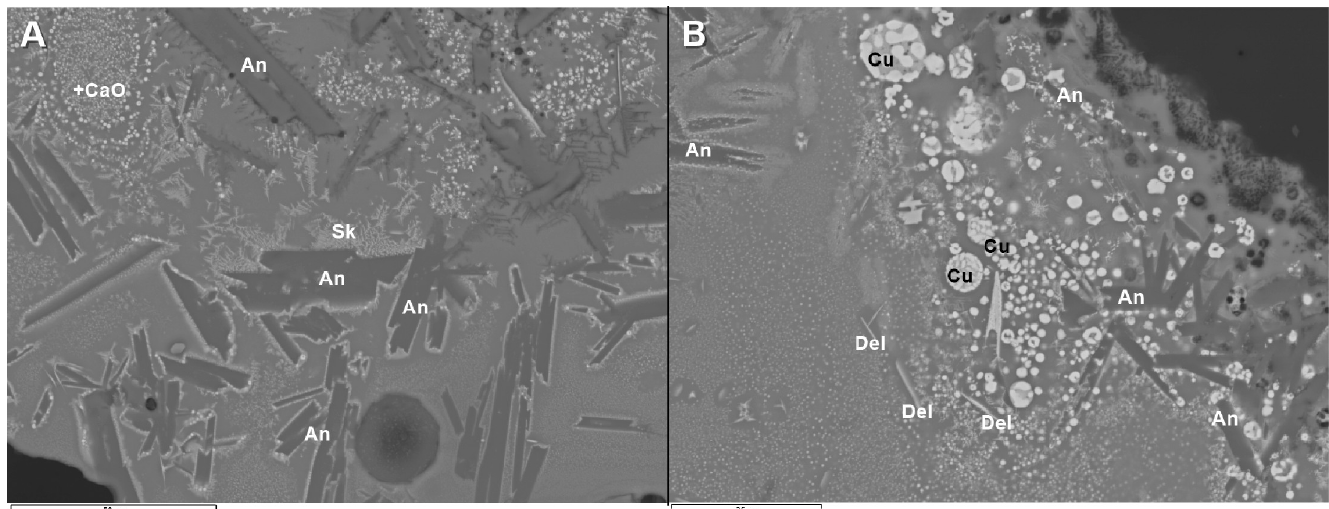
Fig 8. A) BSE micrograph of H12 showing anorthite crystals (An) in a glassy matrix with cuprite exsolutions and skeletal formations (Sk). Note the rounded cluster of cuprite prills at the top left that has higher concentrations of CaO. B) BSE micrograph of H12 showing a cluster of Cu-based prills (Cu) with anorthite needles (An) and some delafossite (Del) crystals. (Scales = 50 and 25 μ m